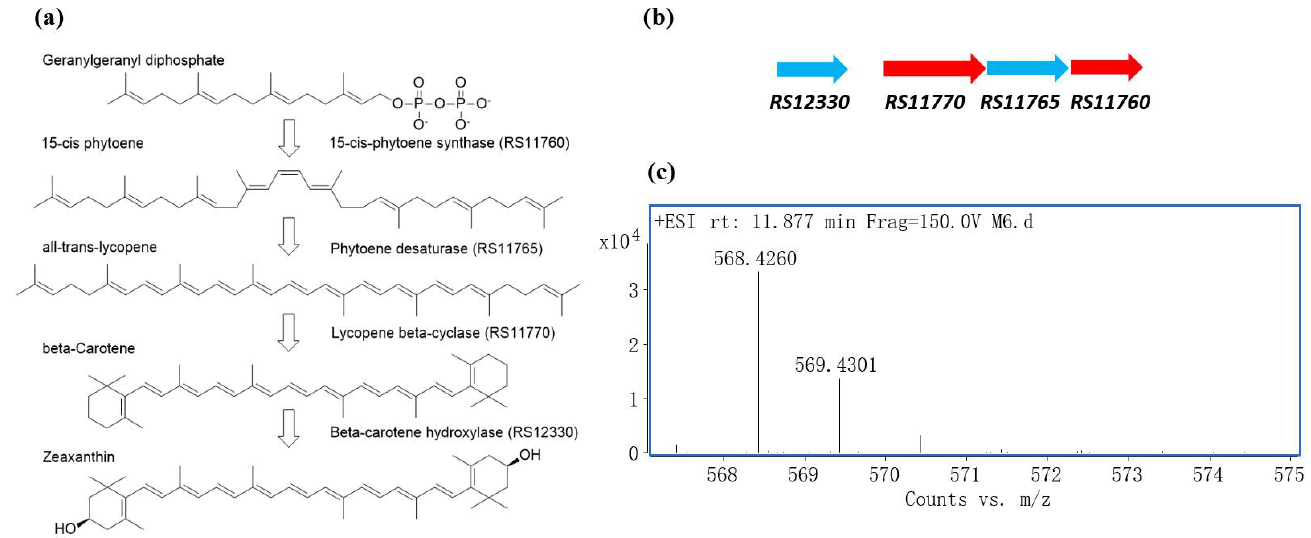
Figure 6. Zeaxanthin production by M6 T . ( a ) Zeaxanthin biosynthesis pathway. ( b ) Zeaxanthin biosynthesis gene cluster found in the genome of M6 T . ( c ) HRMS chromatogram of zeaxanthin in the acetone-methanol extract of M6 T .